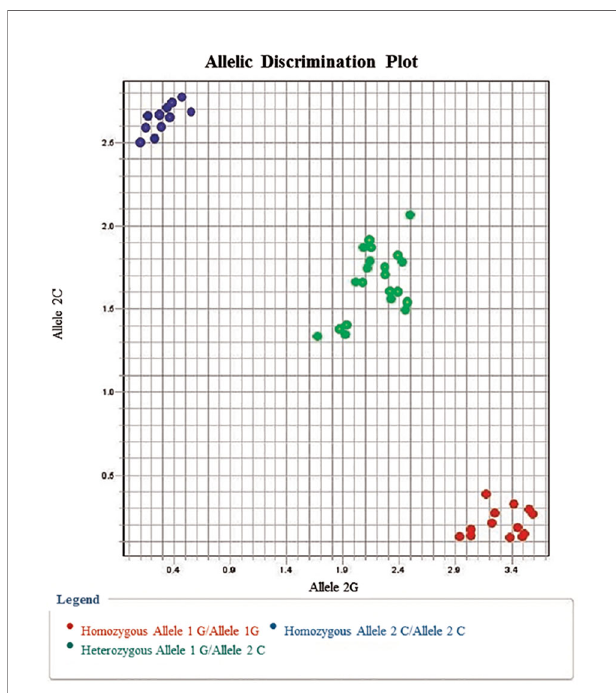
FIGURE 1 | Allelic discrimination plot for EpCAM rs62139665 G/C alleles showing the C/C genotype (represented by upper left dots) near the Y-axis, the G/G genotype (represented by lower right dots) near the X-axis, and the G/C genotype in the middle between both axes.